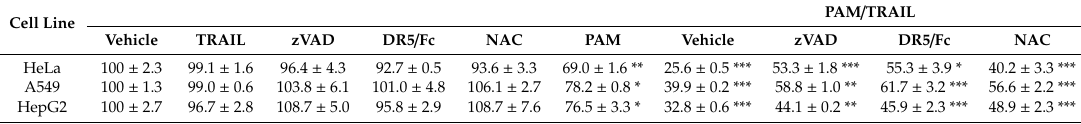
Table 1. Statistical analysis of MTT cell viability assay results (mean ± SD